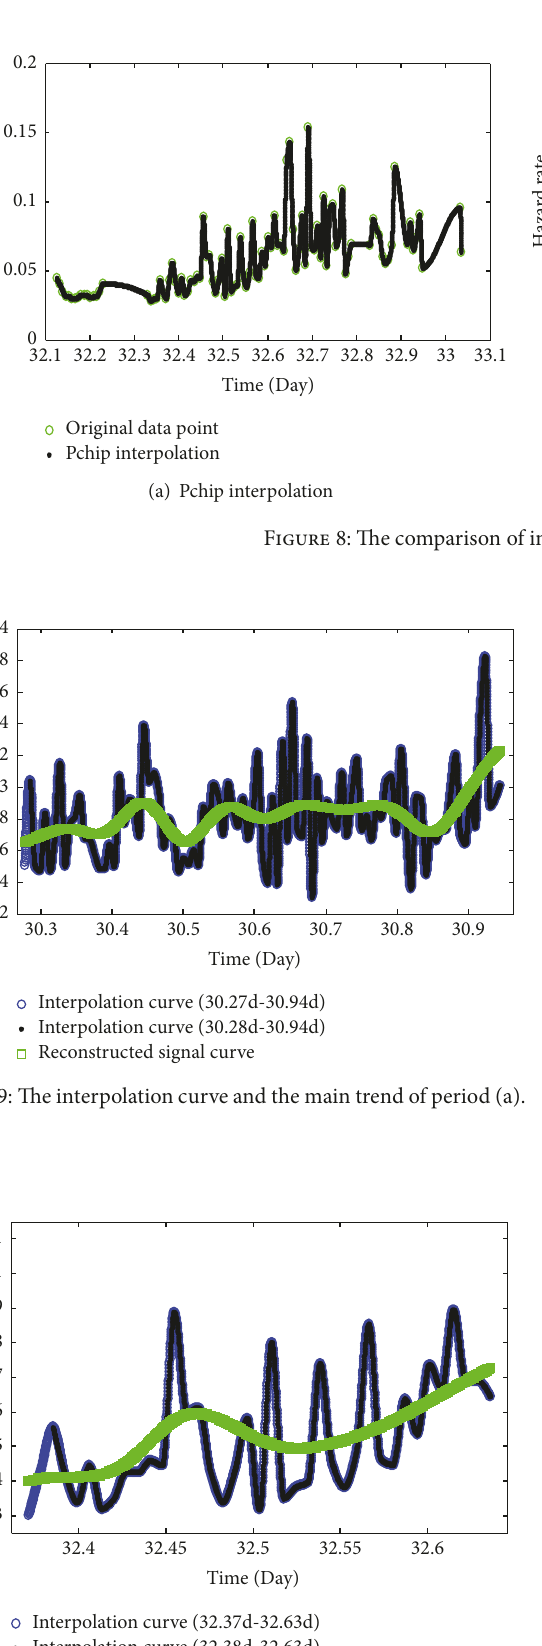
Interpolation curve (32.37d-32.63d) Interpolation curve (32.38d-32.63d) Reconstructed signal curve Figure 10: The interpolationcurveand the main trend of period (c).